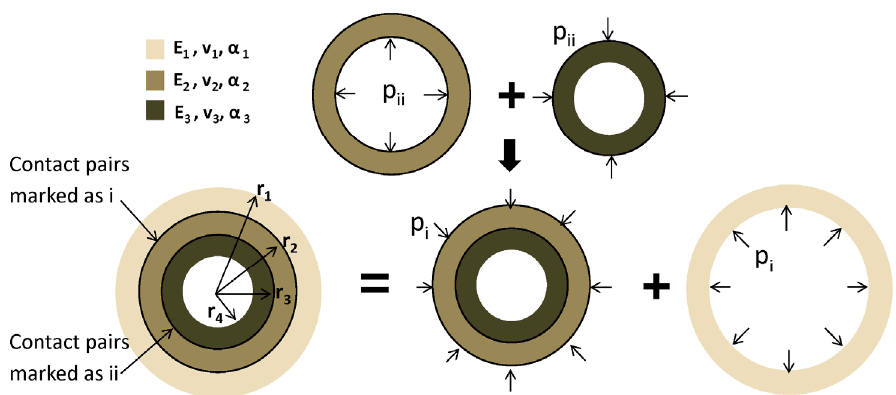
Figure 5. Superposition principle of tri ‐ layer thick ‐ walled cylinders installed from inside to outside.